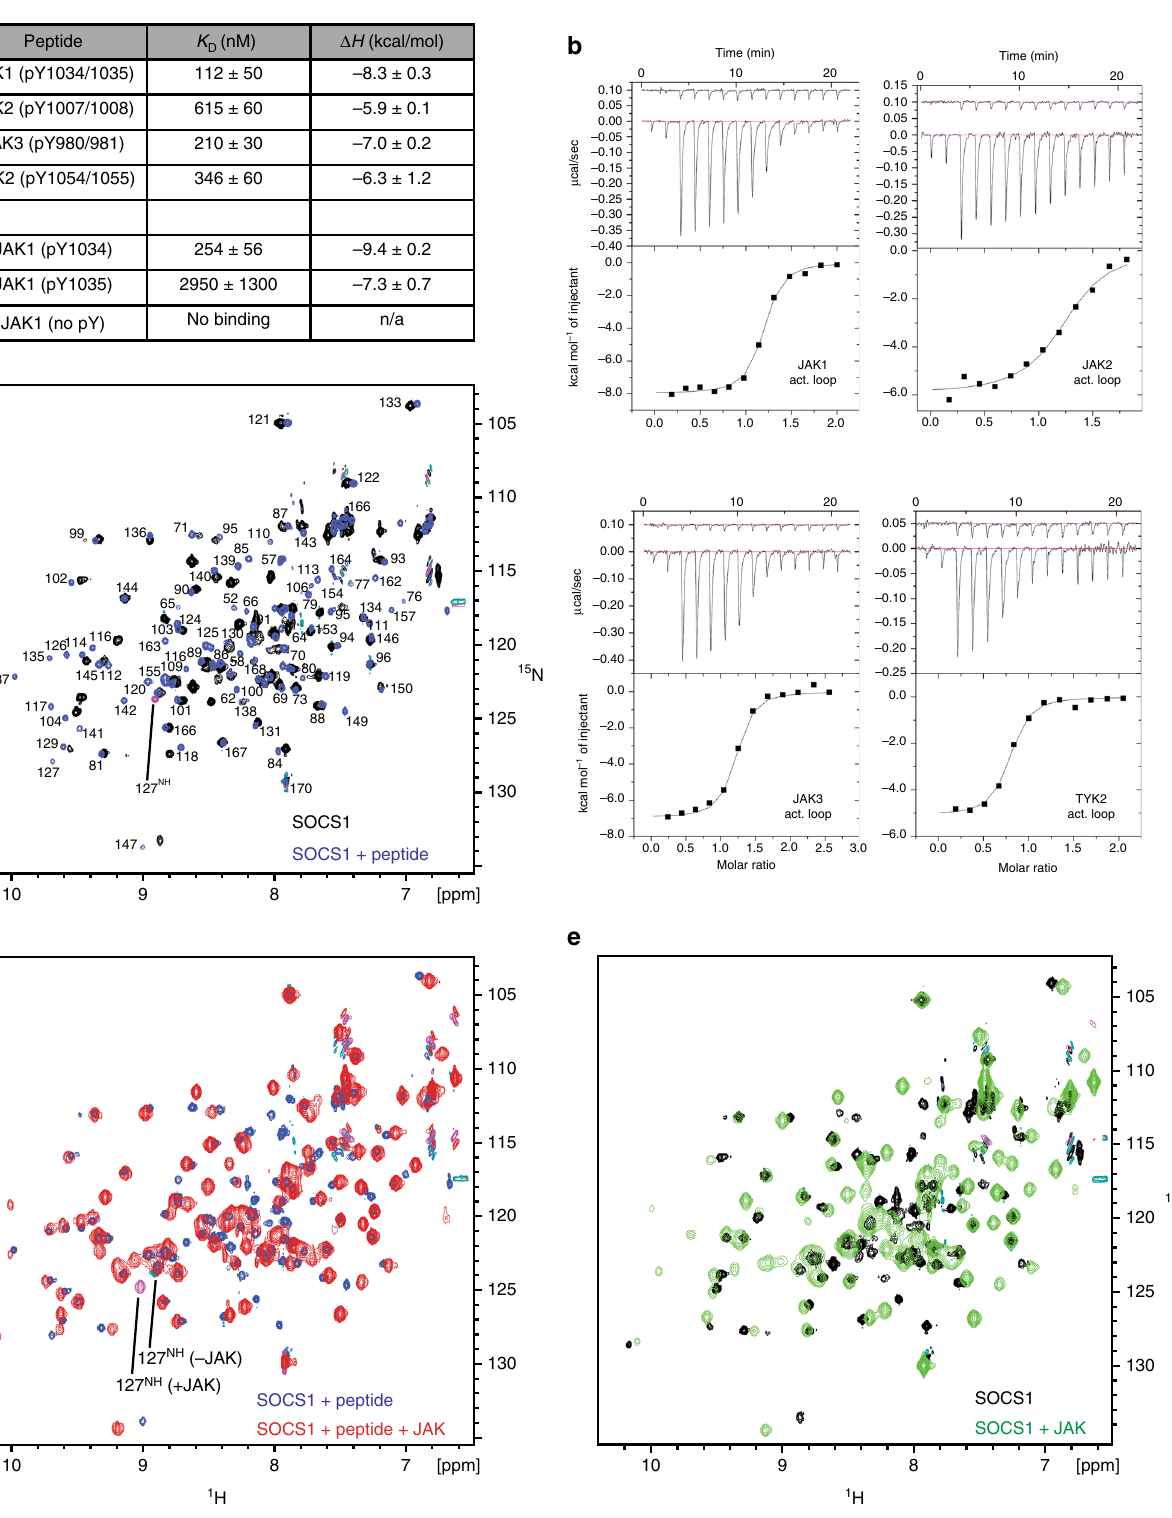
SOCS1 can bind JAK and a pTyr peptide simultaneously . Although SOCS1 could bind activation-loop-derived phospho- peptides with high af fi nity, our attempts to crystallise a SOCS1/ JAK1 complex bound to a pTyr peptide were unsuccessful (possibly due to crystal packing preventing a phosphopeptide from binding the SOCS1 SH2 domain, Supplementary Figure 3).